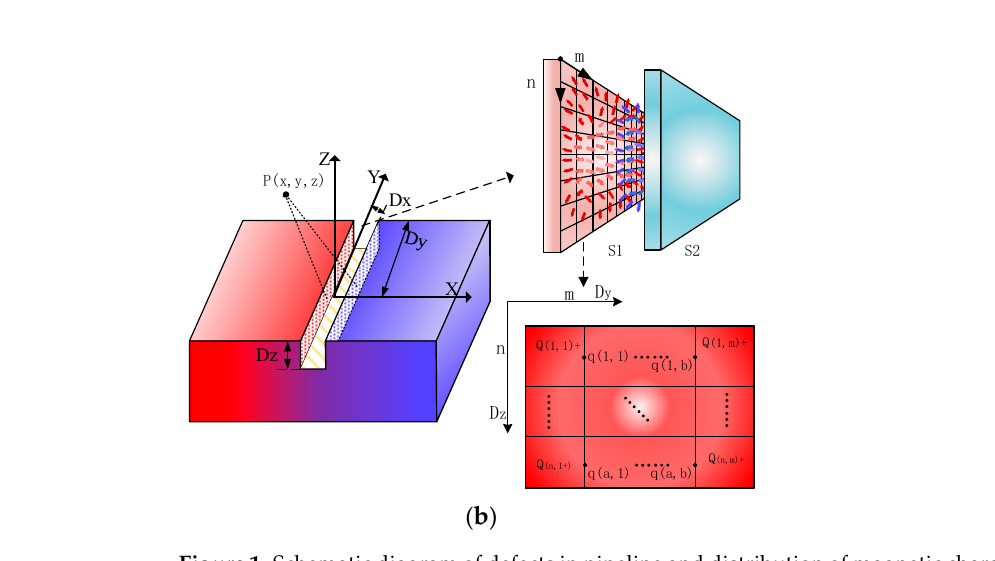
Figure 1. Schematic diagram of defects in pipeline and distribution of magnetic charges. ( a ) Schematic diagram of MFL internal detection of defects in pipeline. ( b ) Schematic diagram of non-uniform distribution of magnetic charges on the side wall of the defect.